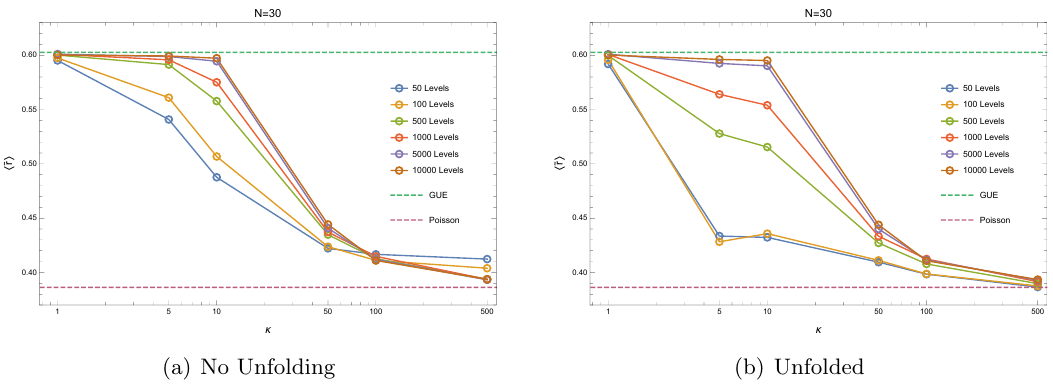
Figure 23 . The mean value of the ~ r -parameter for N = 30 (1 5 (cid:20) 5 500) of (a) the spectrum without unfolding (b) the unfolded spectrum. The average is performed over M = 100 ensembles, respectively. The ~ r -parameter are computed subsectors of the spectra including M levels starting from the ground state ( M = 50 ; 100 ; 500 ; 1000 ; 5000 ; 10000).